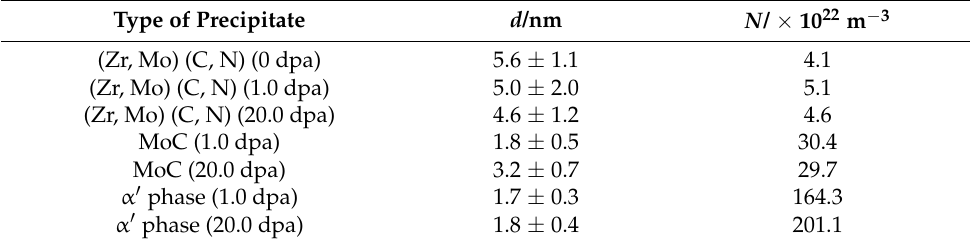
Table 3. The diameter ( d ) and number density ( N ) of precipitates in different irradiation doses. Type of